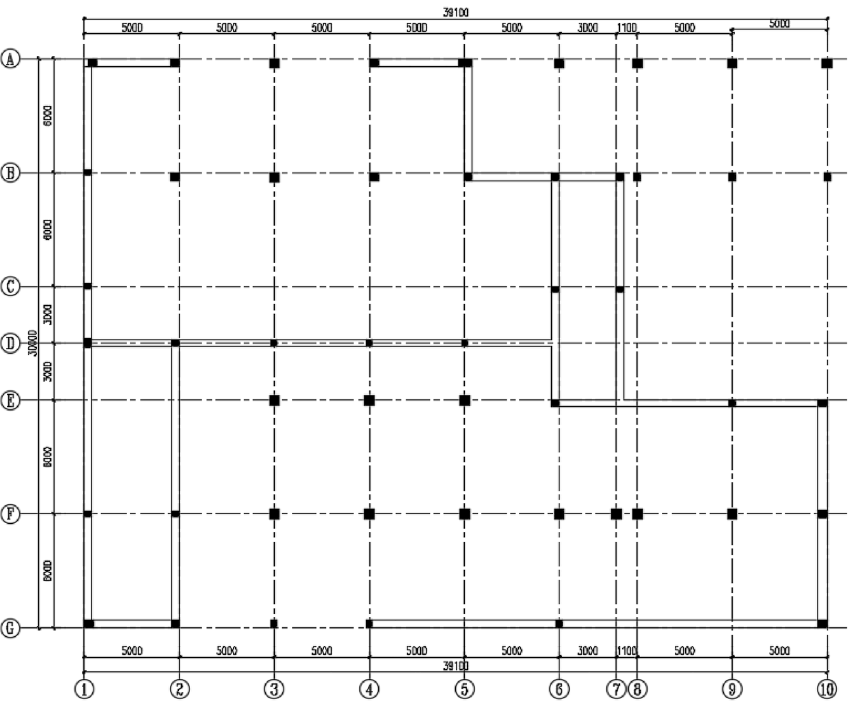
Figure 1. The structure plan of the ammonium sulfate workshop.